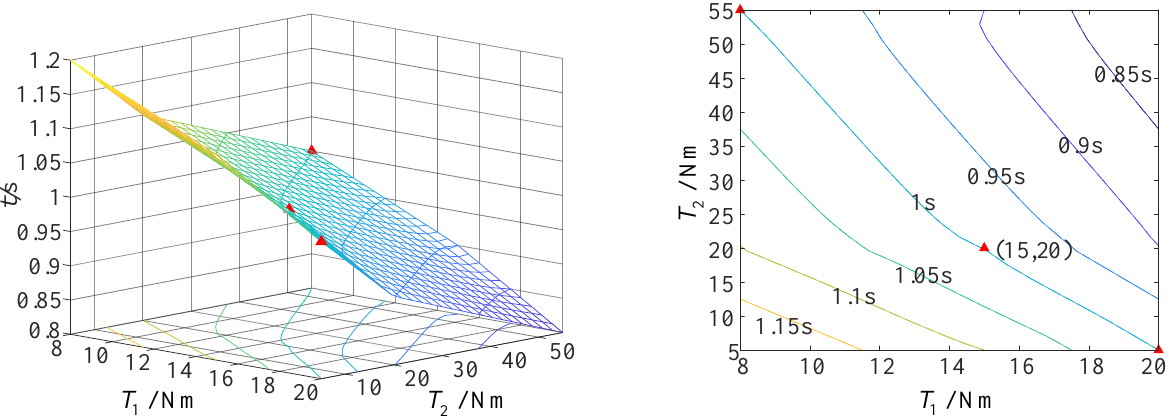
Figure 25. The curve of driving torque and deployment time of folding wing at an airspeed of 50 m/s (fixed-axis – non-fixed-axis stepwise deployment mode).